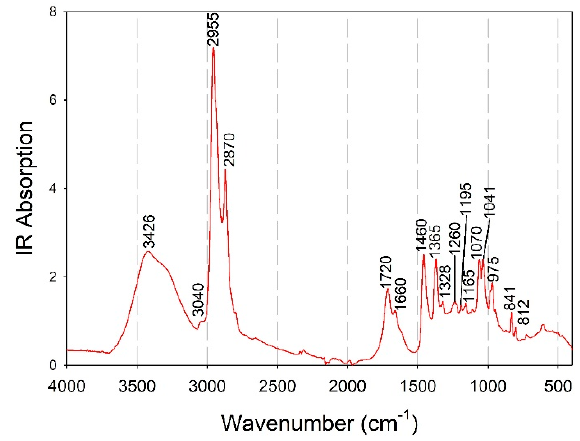
Figure 7. ATR-FTIR spectrum of the ergosterol standard with marked characteristic peaks.